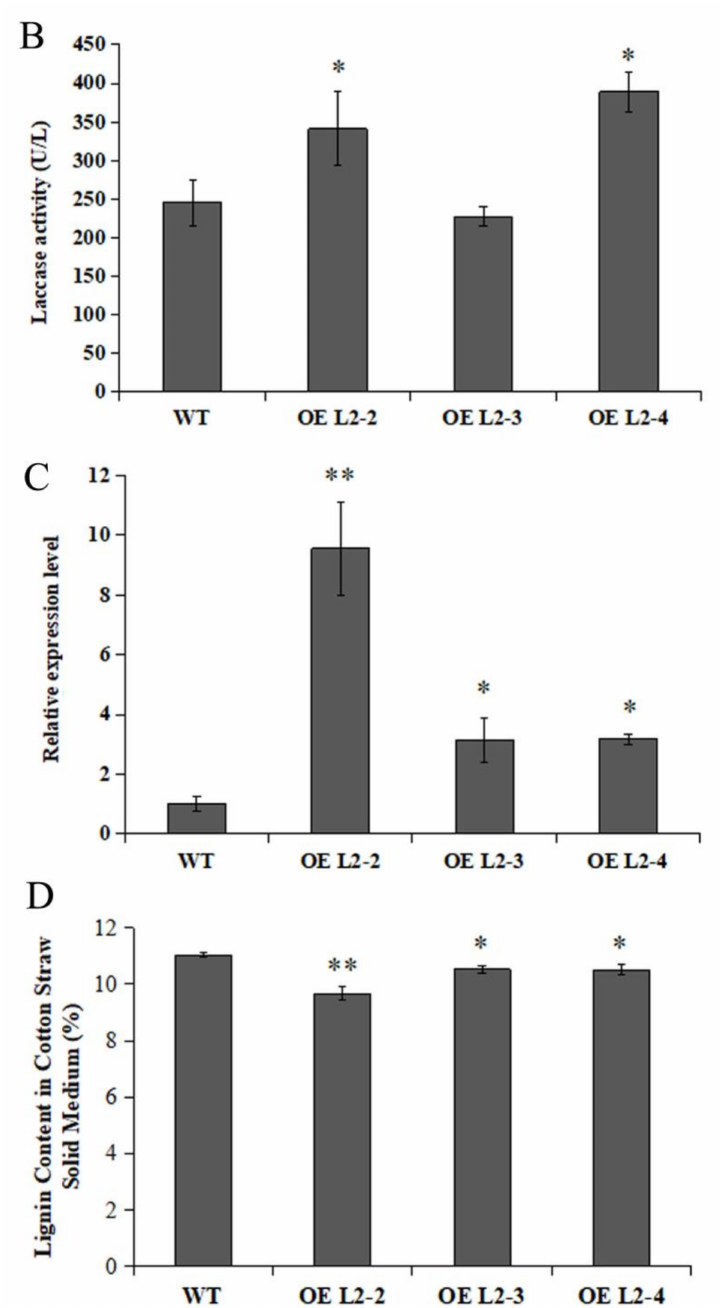
Figure 7. Comparative analysis of wild-type (WT) and randomly selected P. ostreatus transformants (OE L2-2, OE L2-3 and OE L2-4). ( A ) Laccase activities of the wild-type and transformants determined by guaiacol color-changing method; ( B ) Laccase activities produced of wild-type and transformants in cotton-straw medium; ( C ) Analysis of qRT-PCR for the PoLac2 expression of the wild-type and transformants; ( D ) The lignin degradation rate of the wild-type and transformants cultivated in the cotton-straw medium after 30 days. * Denotes significant difference compared to wild-type ( p < 0.05), ** Denotes extremely significant difference compared to wild-type ( p < 0.01). The values are the means ± standard deviation ( n =